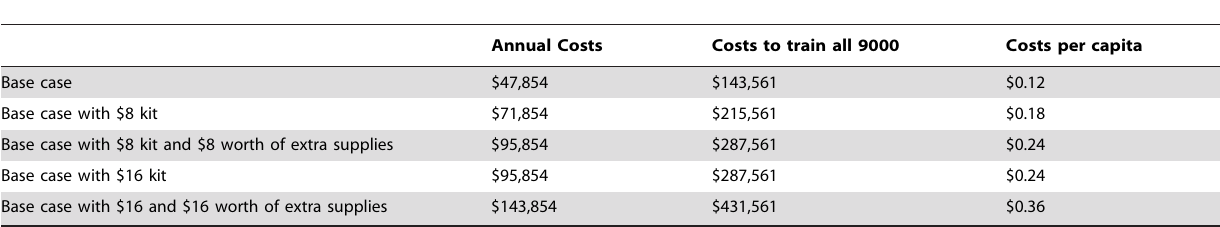
Table 6. Costs per capita of training 9000 lay first-responders for Kampala.